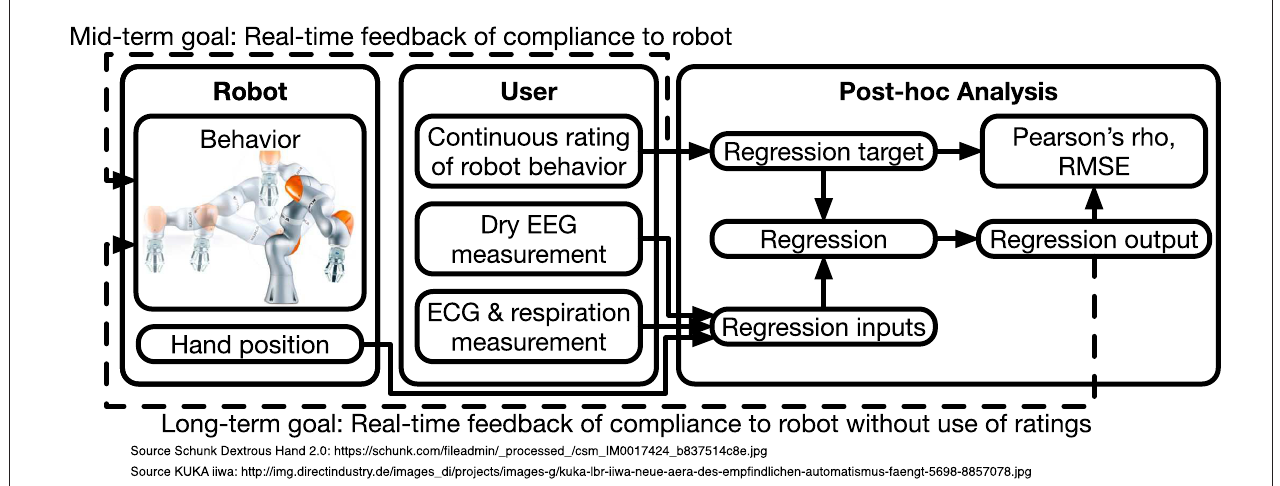
FIGURE 1 | Structural diagram. A robot performs pre-programmed trajectories in the proximity of a user. The user subjectively and continuously rates the human compliance of the trajectories. In parallel, EEG, ECG, and respiration are measured. After the experiments, the EEG, ECG, respiration, and hand position data are used to regress the ratings. We report the correlation coefficient (Pearson’s ρ ) and root mean square error (RMSE) between ratings and regression outputs as intuitive quantitative measures. Our long-term goal is to provide real-time feedback to reinforcement-learning algorithms controlling the robot without explicit user ratings.